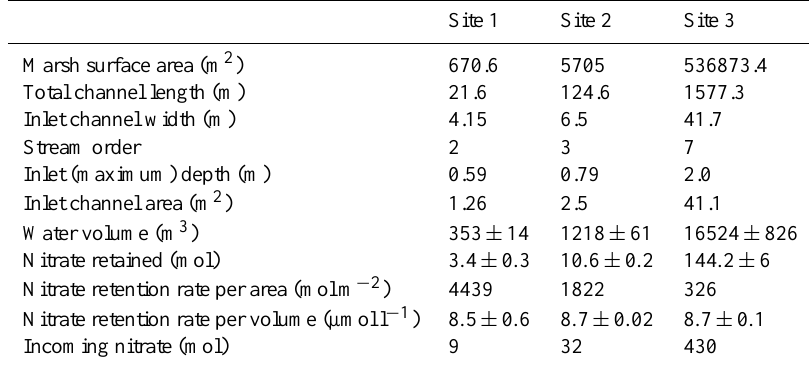
Table 1. Geomorphic characteristics of marshes and mass balance measurements for autumn